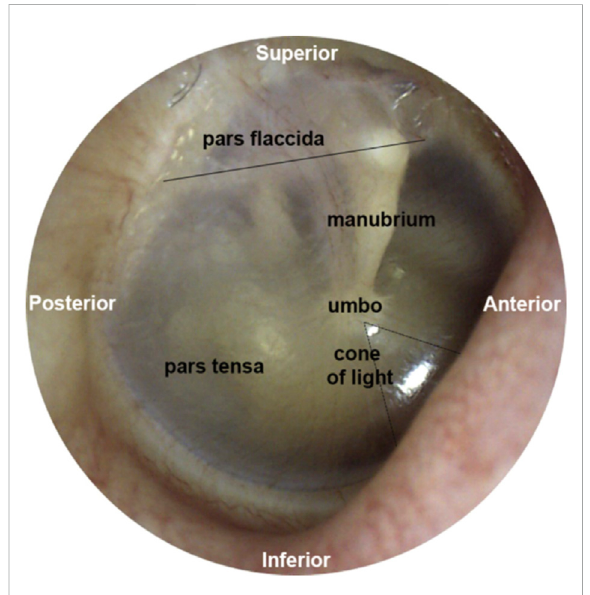
FIGURE 2 This fi gure was previously published in Brister et al. (2020a). Theimageofthemiddleearistakenfromthetympanicmembrane of a right ear. Above the solid black line is pars fl accida, and below pars tensa. The umbo forms the tip of the manubrium. The re fl ection called the cone of light points toward the nose.